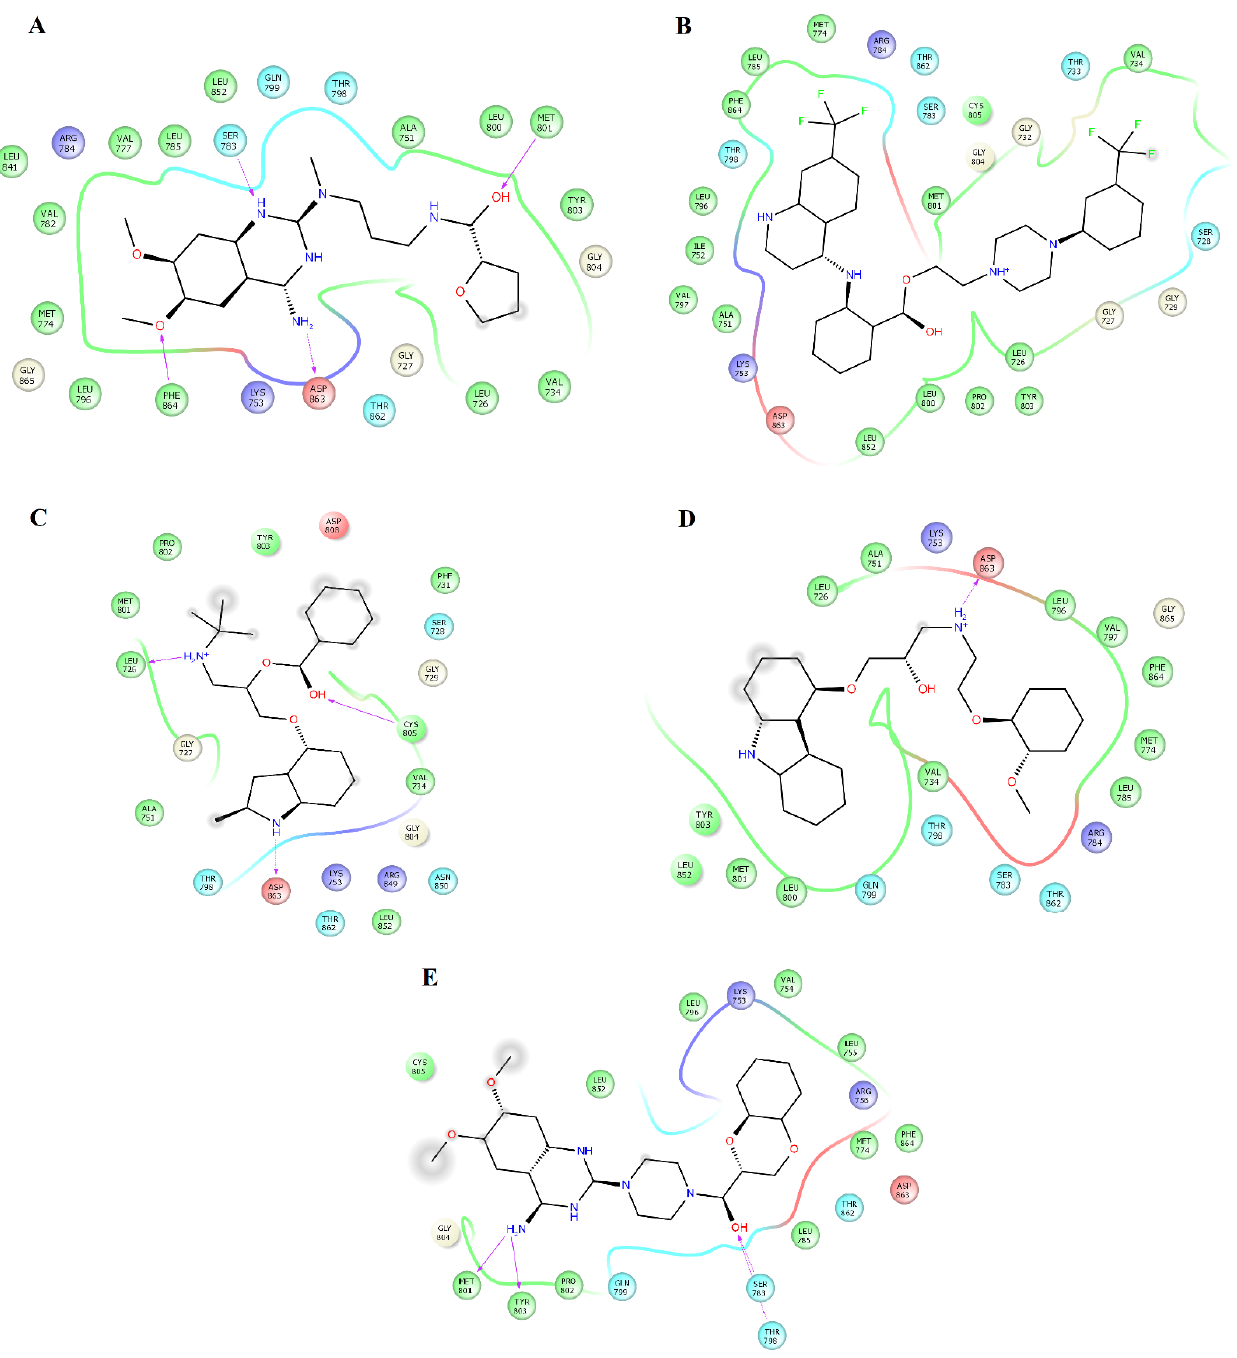
Figure 1. Map of contacts for the complexes between HER2 and alfuzosin, antrafenine, bipindolol, carvedilol, and doxazosin. Binding conformations for HER2 alfuzosin ( A ); HER2 antrafenine ( B ); HER2 bopindolol ( C ); HER2 carvedilol ( D ) and HER2 doxazosin ( E ). The figure was constructed with Maestro Schrödinger version 10.5.